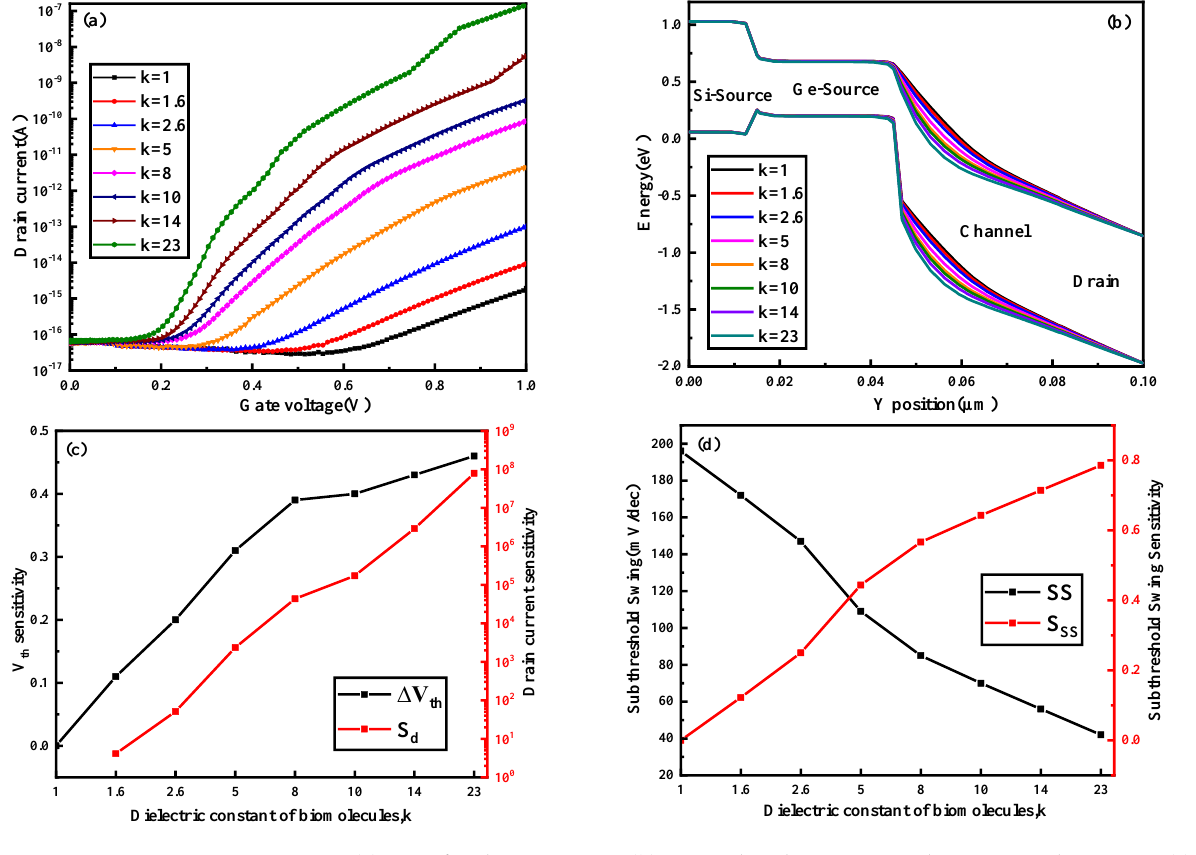
Figure 4. ( a ) Transfer characteristics, ( b ) energy band variation with respect to the y − axis, ( c ) S Vth and S d and ( d ) SS and S SS of the DM − SSTGTFET biosensor for different values of k at V d = 0.5 V, V g = 1 V and t c = 5 nm. 3.2. The Influence of Nanogap Thickness on Biosensor The thickness of the nanogap has different effects on the sensitivity of the biosensor. According to the size of the biomolecules, the thicknesses of the nanogaps used in this paper are 5 nm, 7 nm, 9 nm, 11 nm and 13 nm. As the thickness of the nanogap increases, the transfer curve of the device shifts to the left, the threshold voltage sensitivity decreases, the drain current sensitivity decreases, the subthreshold swing increases and the subthreshold swing sensitivity decreases. These can be seen in Figure 5.